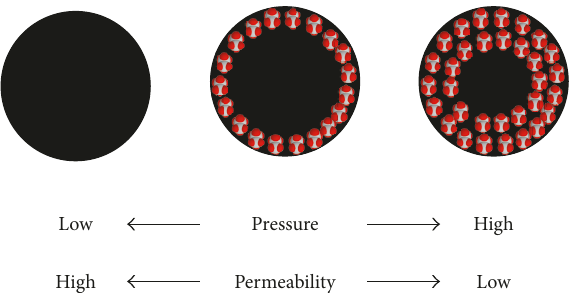
Figure 2: Schematic cross sections of pore throats showing adsorbedliquid/semiliquidethane(redandgreymolecules)restrict- ing flow paths for ethane gas at high gas pressure, resulting in decreased effective permeability to ethane